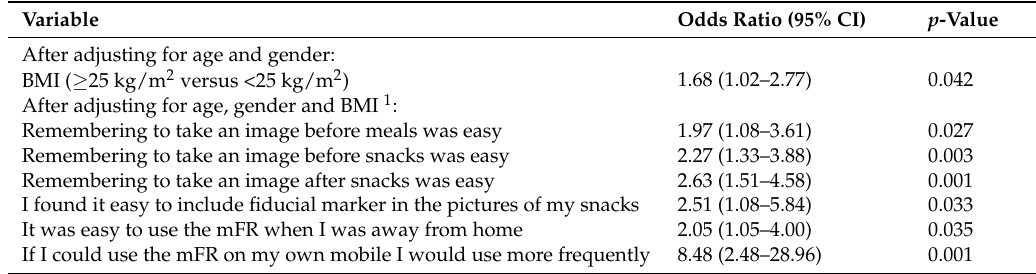
Table 3. Odds ratios of the likelihood of using the Mobile Food Record (mFR) for 14 days or more ( n = 119) compared to less than 14 days ( n = 161) among the young adult and overweight samples 1 . Variable Odds Ratio (95% CI) p -Value After adjusting for age and gender: BMI ( ≥ 25 kg/m 2 versus <25 kg/m 2 )